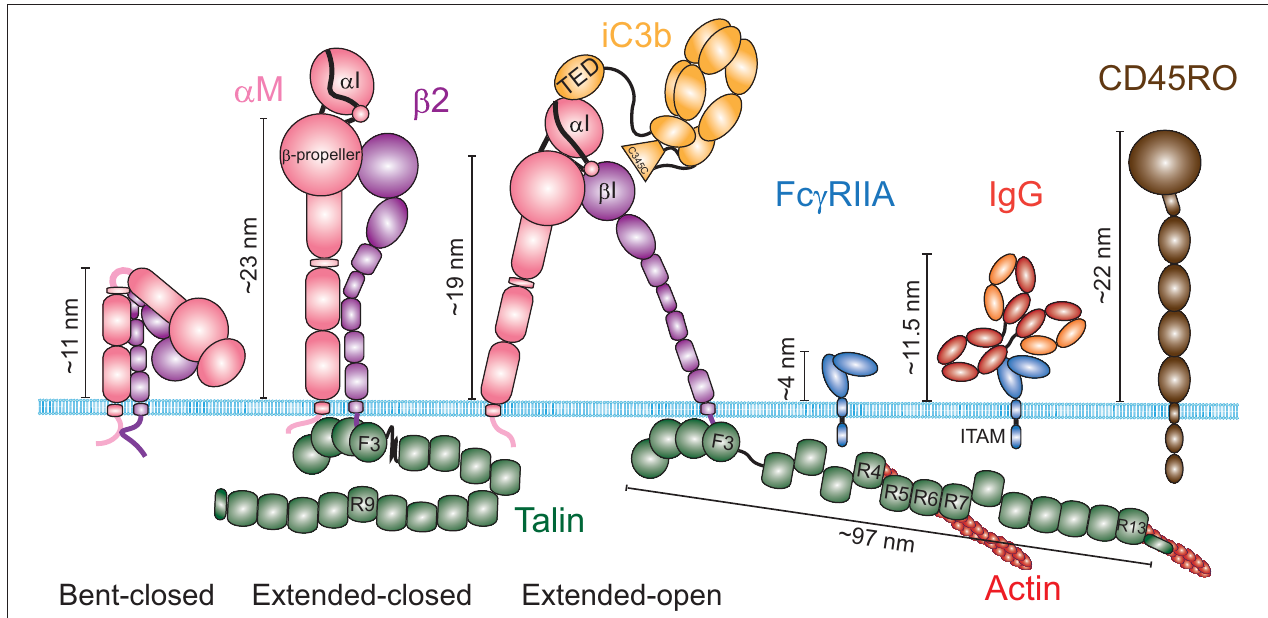
FIGURE 3 | Schematic of the structures of the integrin α M β 2, the Fc γ Receptor IIA and the phosphatase CD45. The integrin α M β 2 (left) exists in at least three distinct conformations: a bent-closed conformation associated with a low affinity for its ligands, an extended-closed conformation associated with an intermediate affinity, and an extended-open conformation associated with a high affinity for its ligands. The current model suggests that integrins are maintained in an autoinhibited bent conformation by the interaction of the cytosolic domains of the α and the β chains. The switch from a bent to an extended conformation requires binding of Talin to the cytosolic domain of the β chain. The pulling force generated by the actin cytoskeleton through Talin induces the open conformation, when the integrin is attached to an immobile ligand. The ligand iC3b binds through its TED domain to the α I domain of α M. Some evidence suggest that the C345C domain could associate with the β I domain of β 2, in addition to the TED- α I association. Contrary to integrins, the structure of Fc γ RIIA shows no conformational change upon binding to an immunoglobulin G. Average heights estimated from the membrane surface for these receptors in each conformation and for the RO isoform of CD45 are shown. For the extended conformations of α M β 2, the indicated height corresponds to the height of the β -propeller. Talin was not schematized to scale, but its estimated length at a focal adhesion is